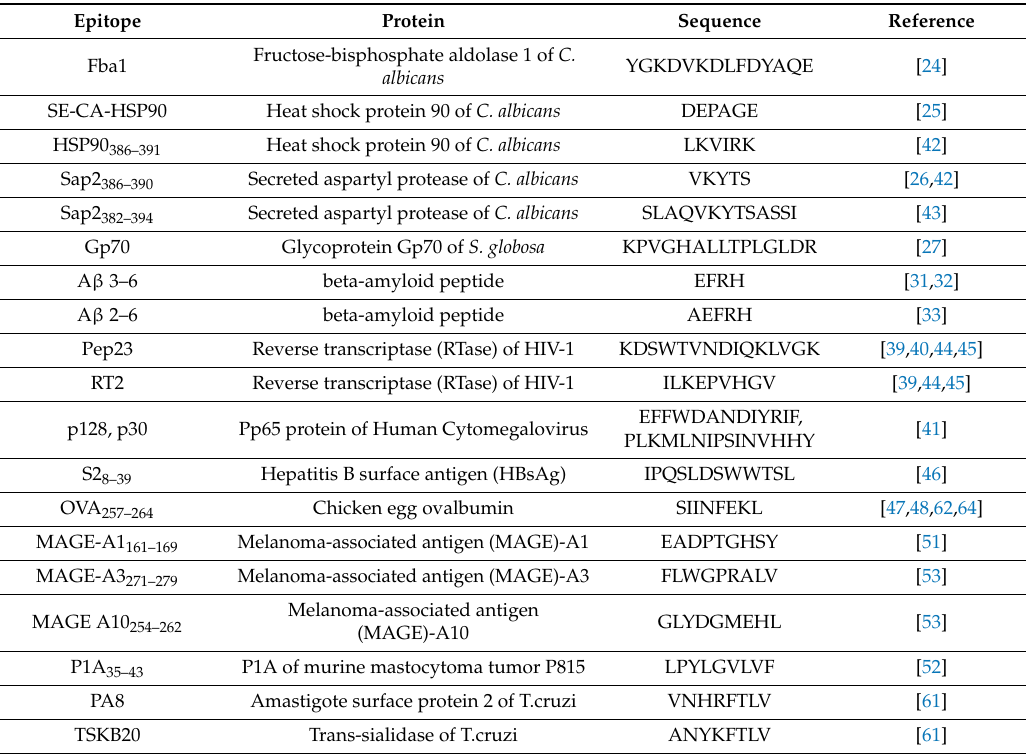
Table 1. B and T epitopes expressed on filamentous bacteriophages and mentioned in the text. Epitope Protein Sequence